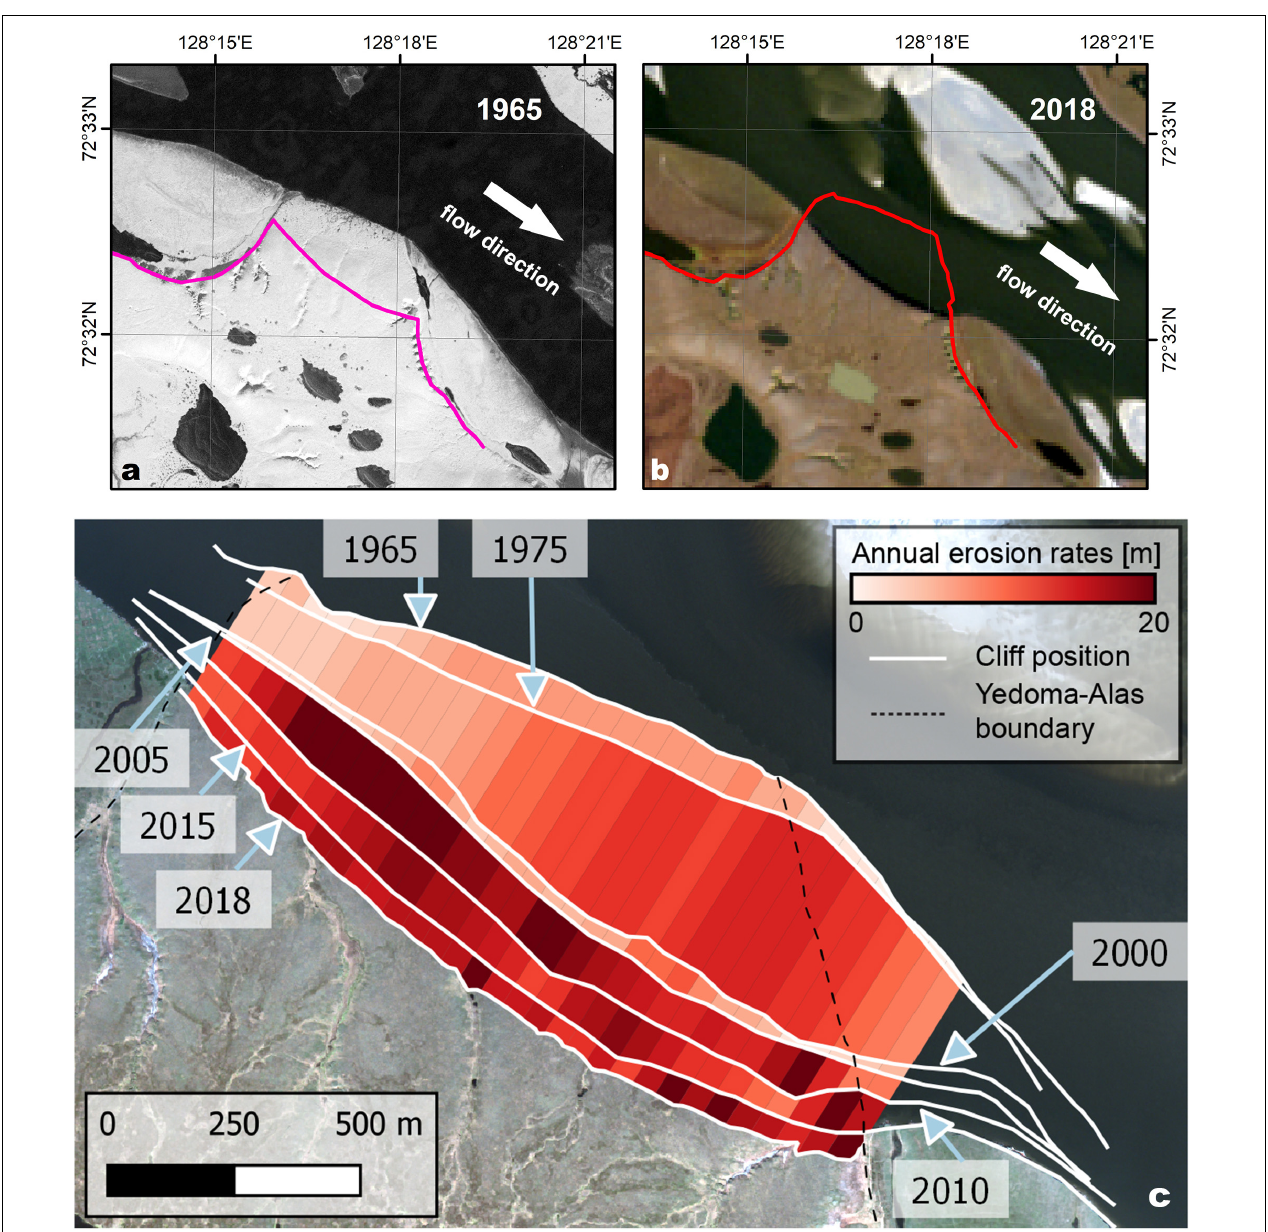
FIGURE 5 | Erosion rates at Sobo-Sise Cliff. (a) Corona image from 1965 showing the Sobo-Sise Cliff. Line in purple shows the cliff front in 2018. (b) Landsat 8 image from 2018 showing the Sobo-Sise Cliff. Line in red shows the cliff front in 1965. (c) Average annual erosion rates per segment and cliff lines for